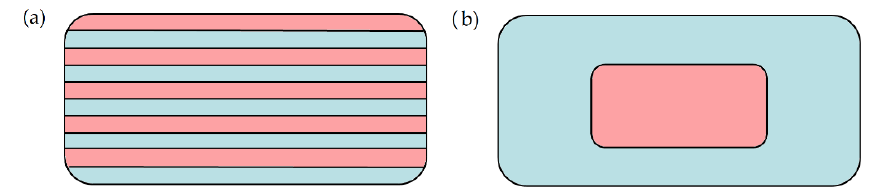
Figure 2. Cross-section of the constructed drug dosage forms in the article of Goyanes et al. ( a ) Sec- tioned multilayer tablet, ( b ) sectioned DuoCaplet (caplet in caplet) [35].